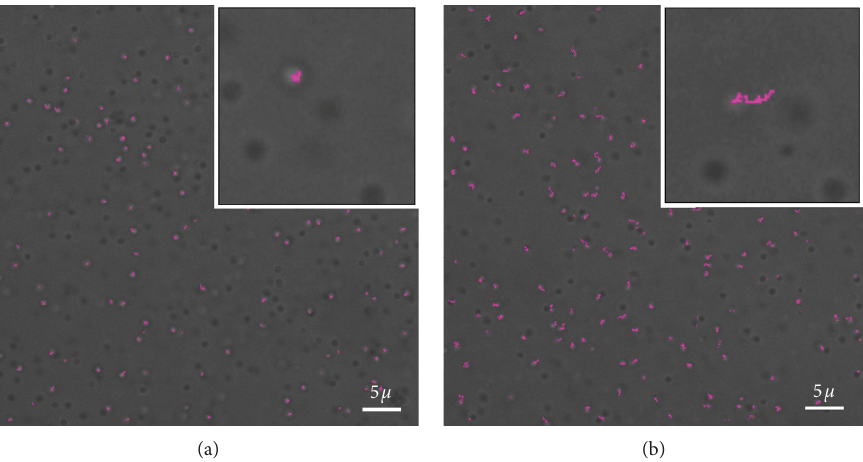
Figure 8: The trajectory of 5 seconds of the SiO 2 -PNIPAM probes in PNIPAM dispersion at (a) 20 right show the amplified record of the single particle movements.